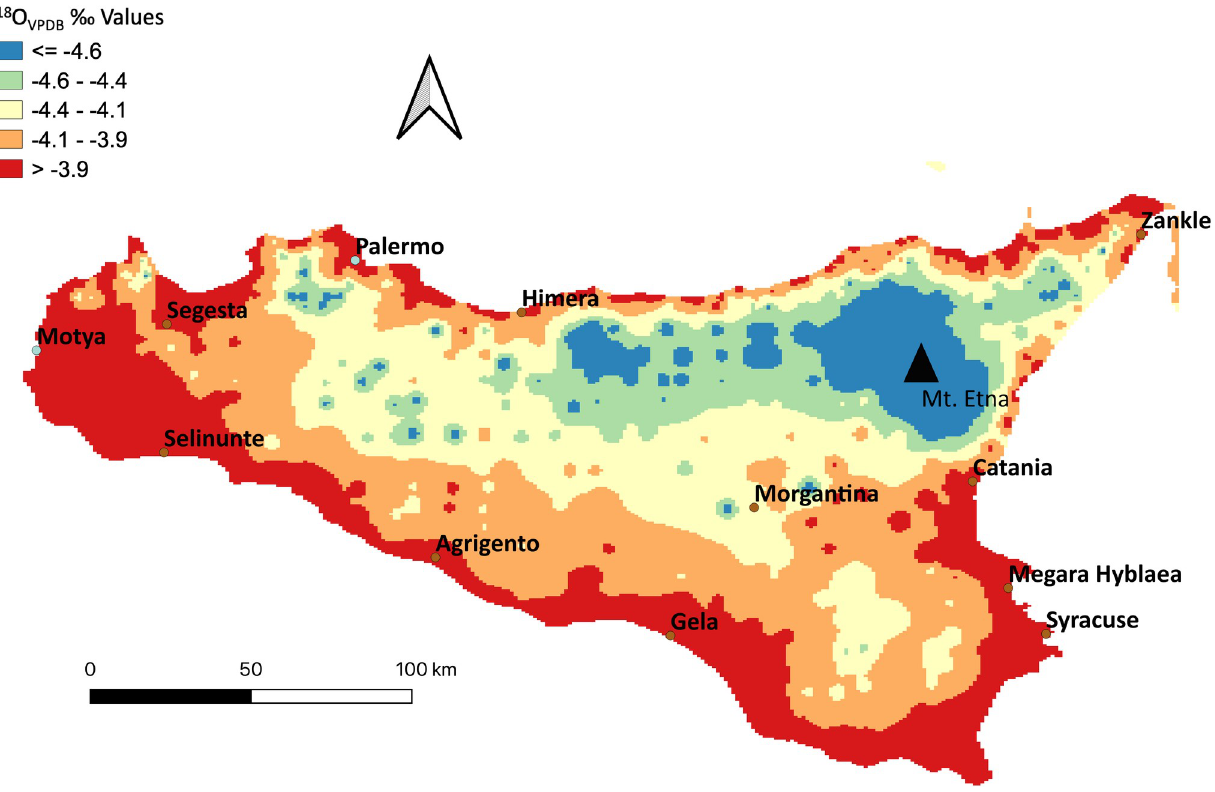
Fig 3. Map of predicted δ 18 O VPDB variability on Sicily. An Inverse Distance Weighting (IDW) Interpolation was created in QGIS from collected modern water, modern teeth, and calculated values from OIPC [52]. Values from OIPC were calculated by inputting longitude, latitude, and altitude of locations across Sicily. Values from modern water and OIPC were converted from δ 18 O VSMOW to δ 18 O VPDB ‰ [55, 56].